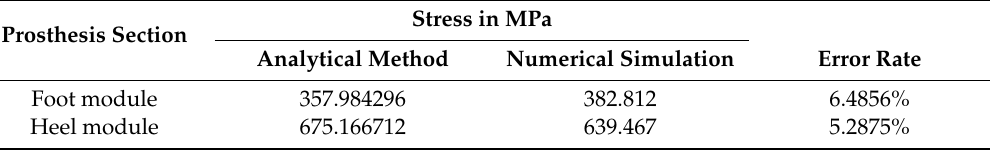
Table 4. Comparison of numerically and analytically computed